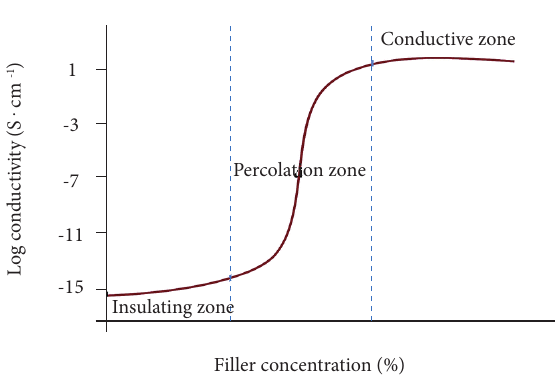
Figure 4. The percolation zone of conductive fillers reinforced polymer composites (Ruschau et al. 1992).